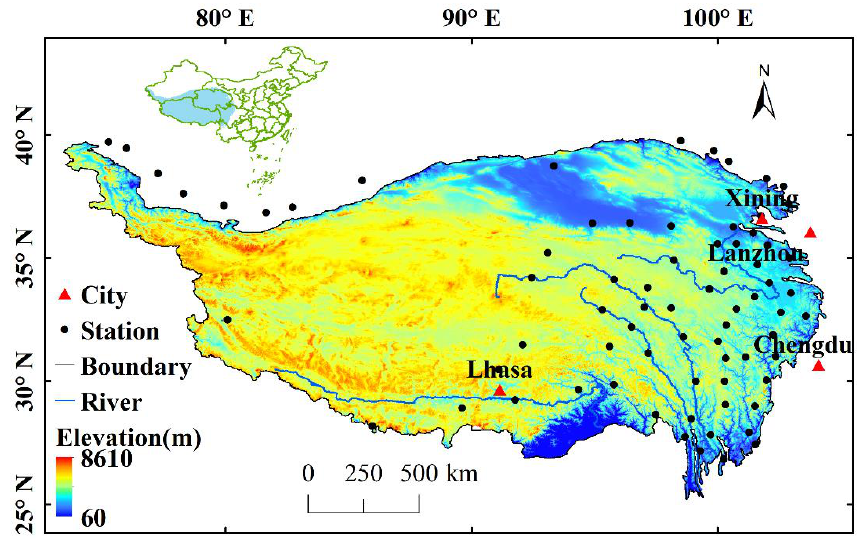
Figure 1. Location of the study area and the distribution of meteorological stations.